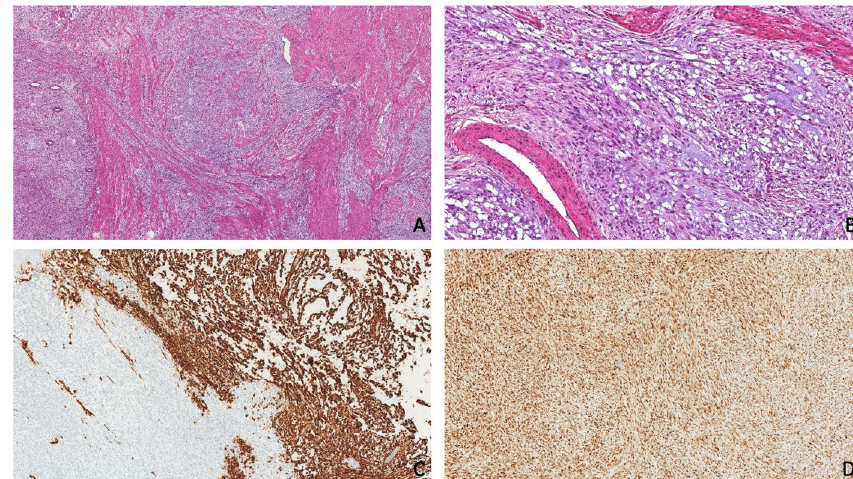
Fig. 1 BCOR HG-ESS from hysterectomy specimen. A H&E section of endomyometrium at 40X magnification showing fascicular growth pattern of BCOR HG-ESS set within a myxoid stroma. Incorporated benign endometrial glands are seen at left. B H&E section of endomyometrium at 200X magnification showing atypical spindle cells arranged in short fascicles set within a fibromyxoid stroma. C CD10 immunohistochemistry at 100X magnification. Note the zones of strong/diffuse expression (right) and adjacent negative population of neoplastic cells (left). D Cyclin D1 immunohistochemistry showing strong/diffuse expression at 100X